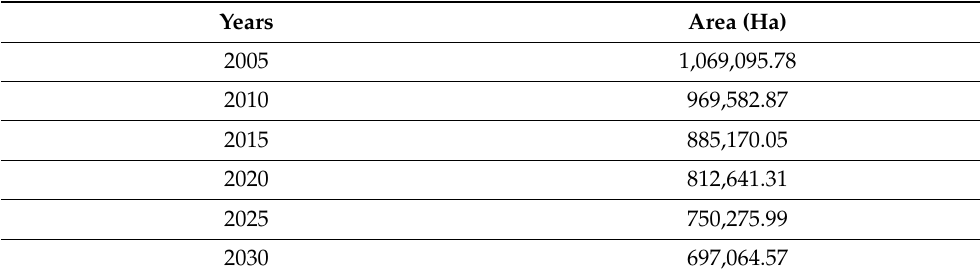
Table 4. The crosstabulation table for land cover predictions in West Java in 2030. Cross Tabulation 2005 and 2030 Unit (km sq)